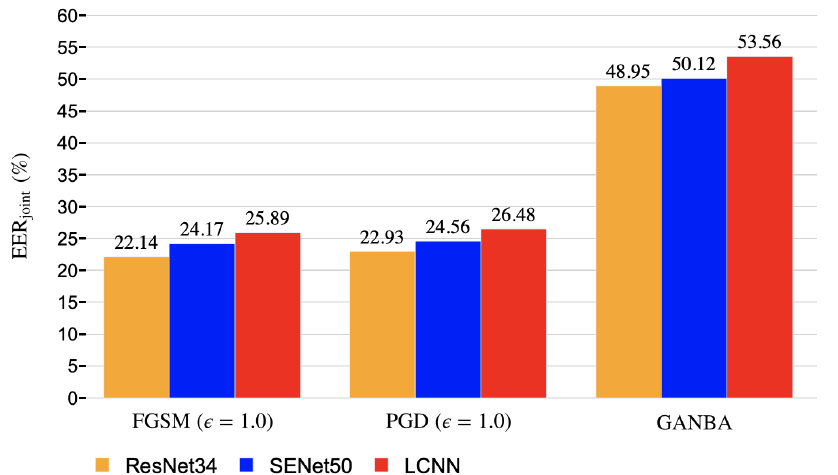
Figure 5. EER joint (%) of the black-box adversarial spoofing attacks evaluated on the ASVspoof 2019 logical access (LA) test dataset with the state-of-the-art TDNN + PLDA / LCNN biometric system. There are three attackers (student systems) which use the ResNet34, SENet50 and LCNN as PAD sys- tem, respectively. The ASV system of the attacker is a TDNN + b-vector system. Every student system generates three types of attacks: FGSM ( (cid:101) = 1.0 ) , PGD ( (cid:101) = 1.0 ) and the proposed GANBA